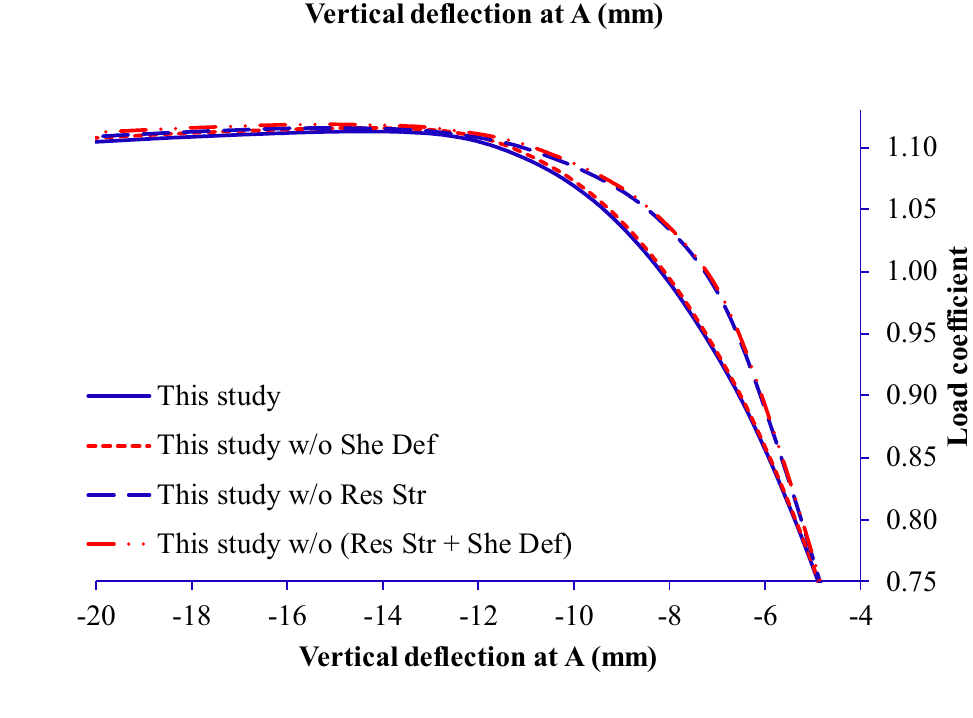
Fig. 15 Load-vertical deflec- tion relationship at A of six- story